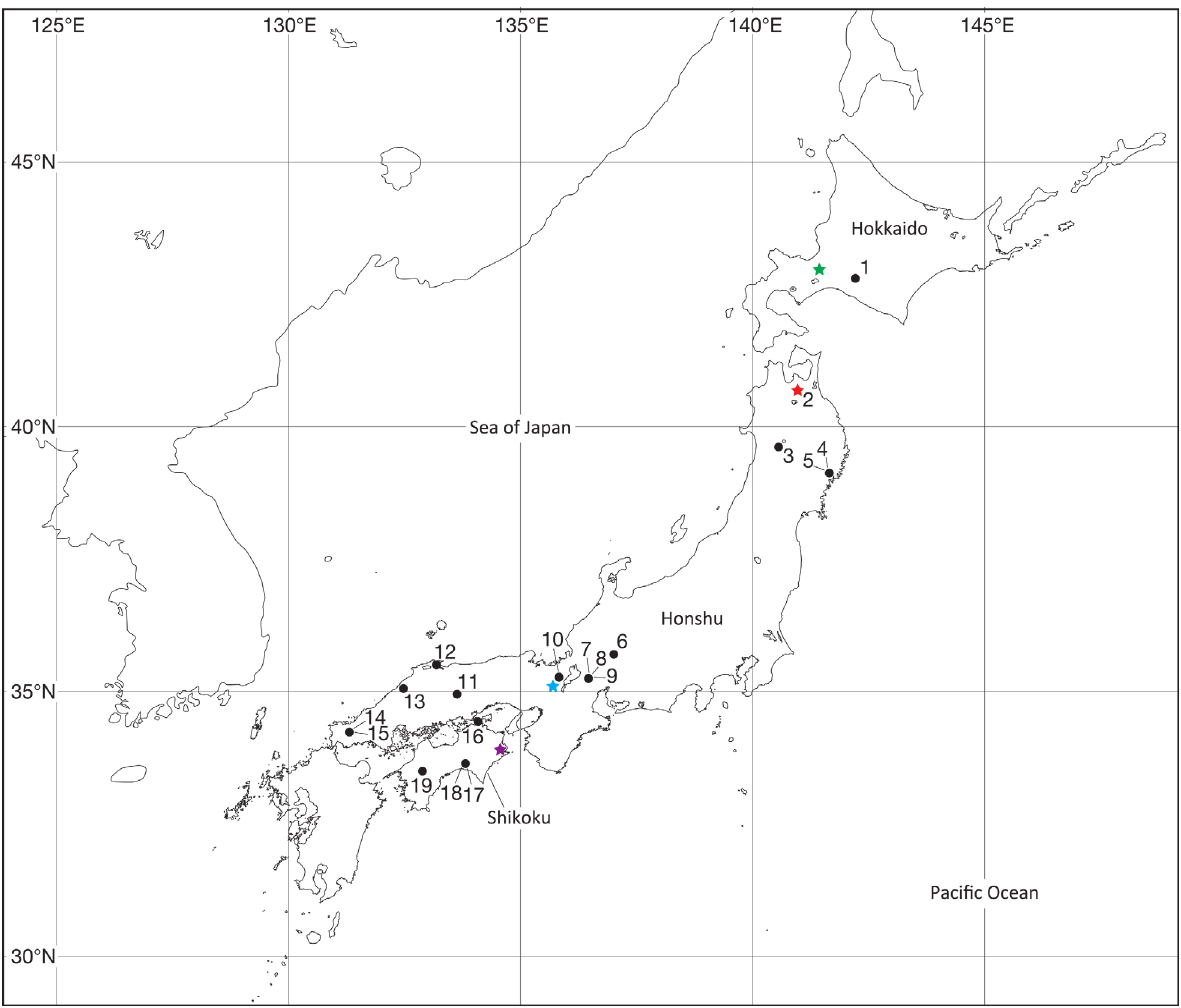
Figure 1. Map showing the collection localities of the specimens examined in this study and type localities of the known Japanese Pseudocrangonyx species. The closed circles indicate the localities of the referred materials used for the phylogenetic analyses. The star in red denotes the type locality of the new species; in purple, P . shikokunis ; in blue, P . kyotonis ; and in green, P . yezonis . Names of localities are shown in Table